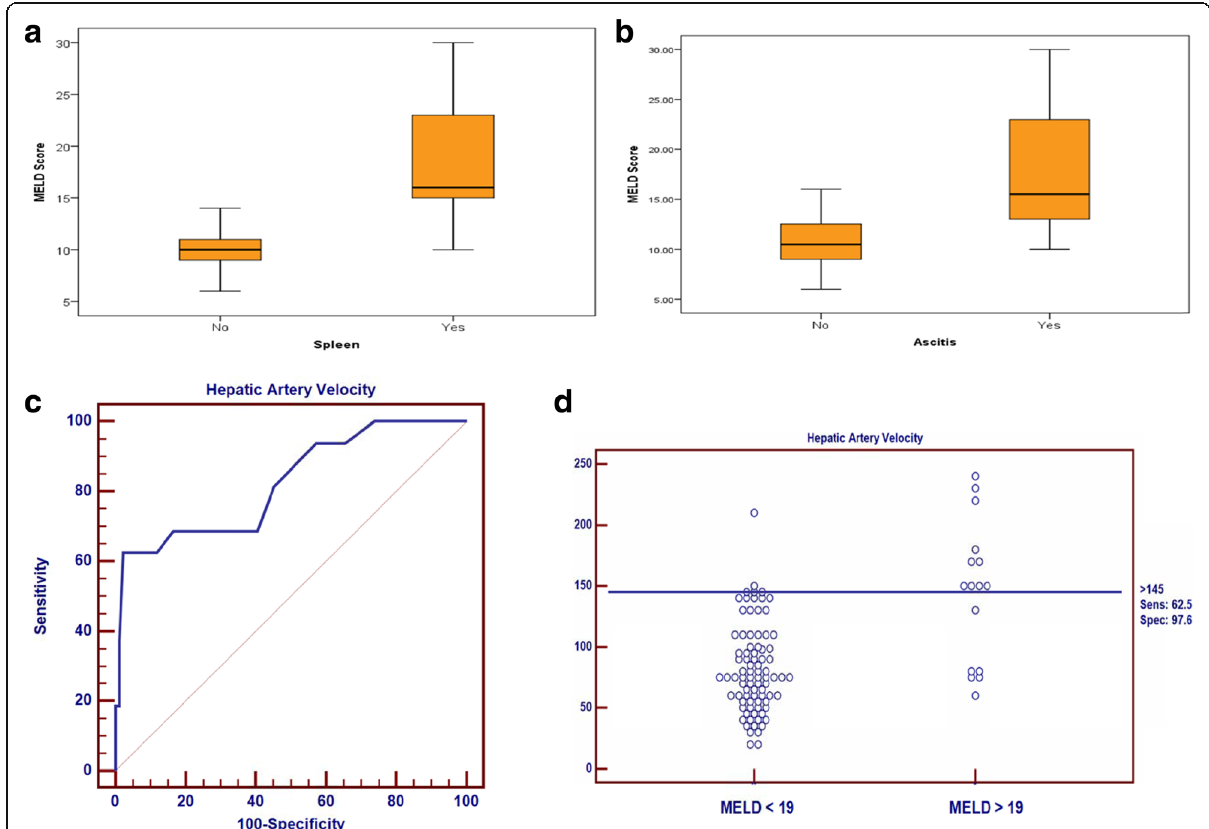
Fig. 2 a Correlation between spleen and MELD by Box plot. b Correlation between ascites and MELD by Box plot. c ROC curve analysis of hepatic artery velocity in prediction of high MELD in cirrhotic patients. Sensitivity = 62.50%, specificity = 97.62% and cut-off value > 145 cm/s. d Scatter plot of MELD score and HAV (cm/s) solid line showing the cut-off point > 145 cm/s